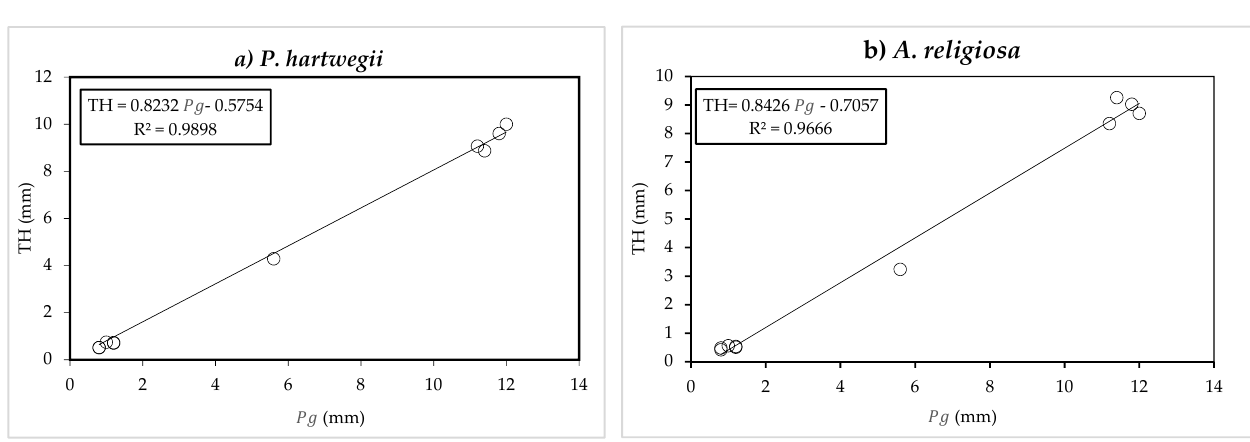
Figure 3. Relationship between the translocation flow and incident precipitation of the events that met the canopy saturation condition, as proposed by Gash, for ( a ) P. hartwegii and ( b ) A. religiosa .